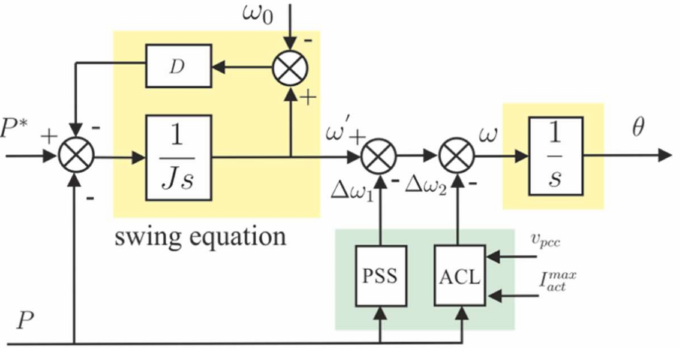
Figure 5. Active power synchronization loop.